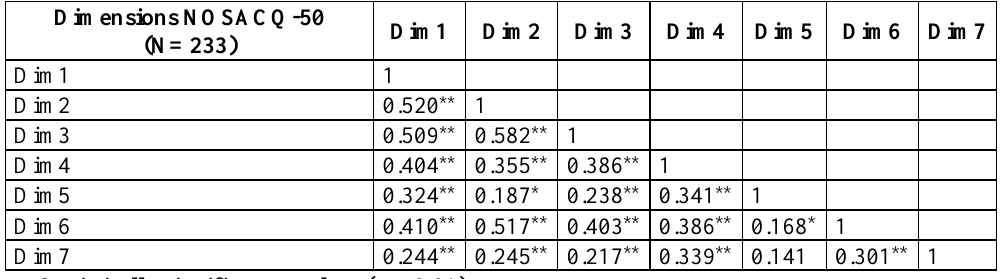
Table 2. Correlations of Dimensions from the Questionnaire NOSACQ-50 Dimensions NOSACQ-50